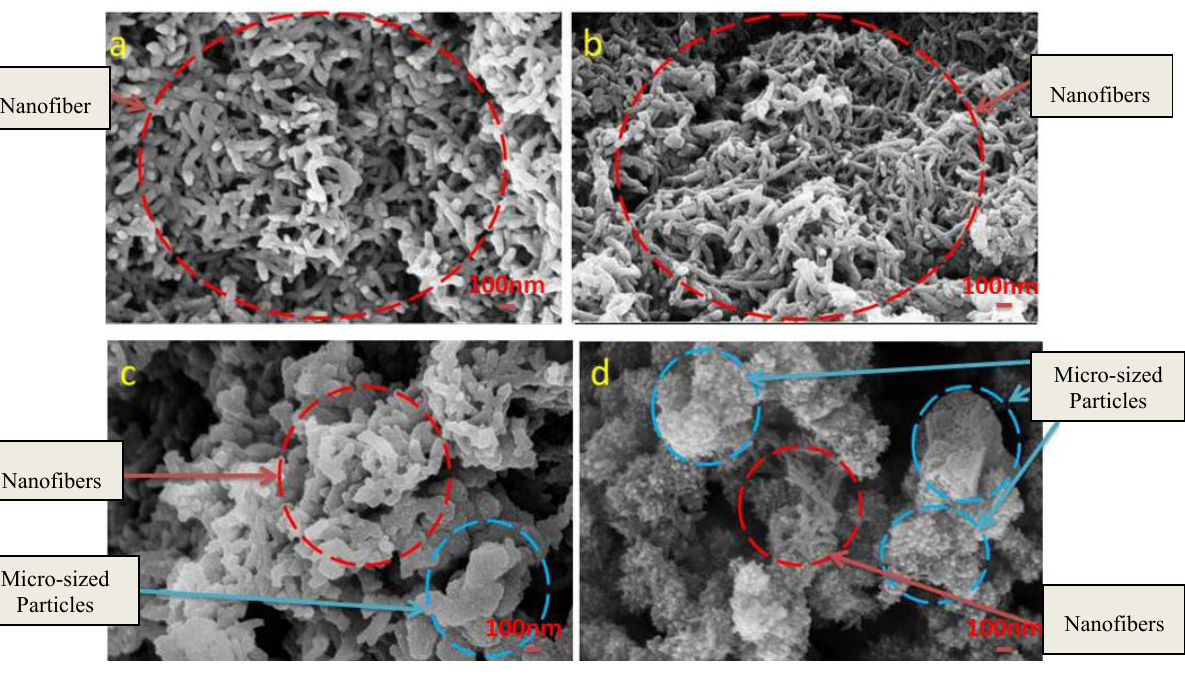
Figure 3. FESEM image of synthesized polyaniline by interfacial polymerization method with ( a ) 4.0; ( b ) 2.0; ( c ) 1.0; ( d ) 0.5 monomer/oxidant molar ratios.